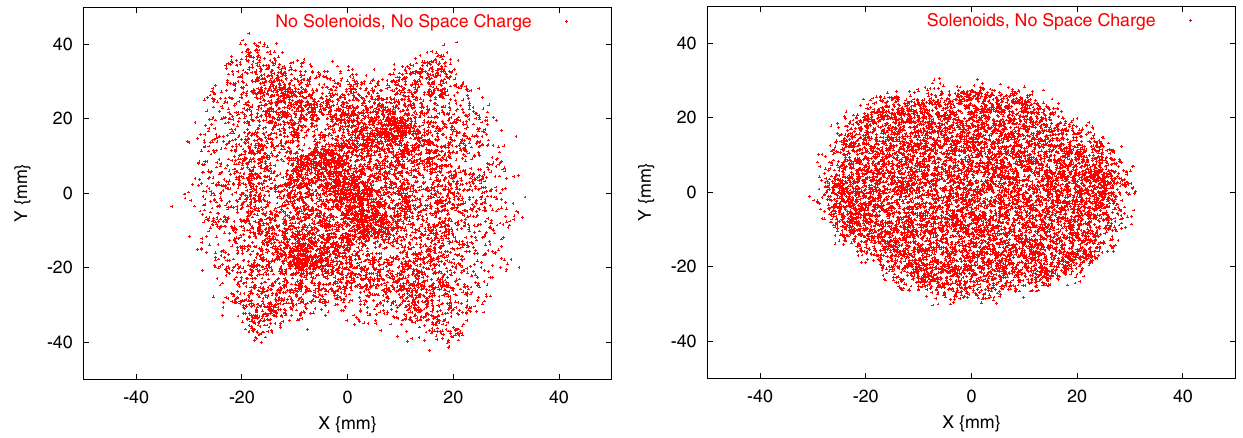
FIG. 1. Results of painting into a rotating beam eigenmode with linearly increasing emittance. (Left) Degenerate eigenfunctions couple. (Right) Solenoids can be added to the lattice to decouple the